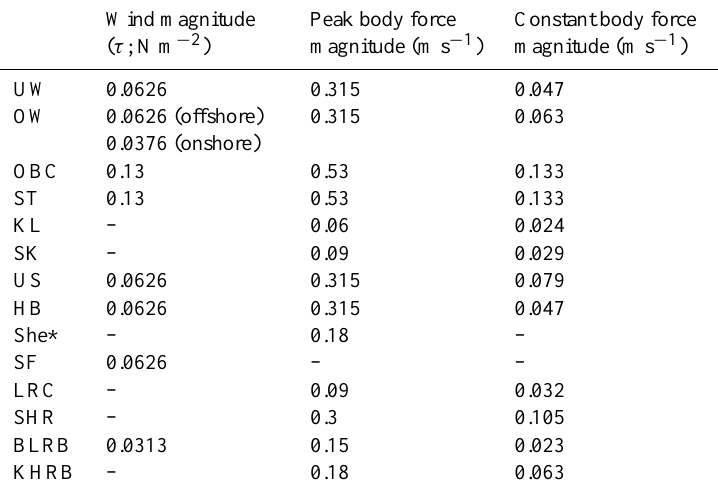
Table 5. Temporal variations in forcing for all model